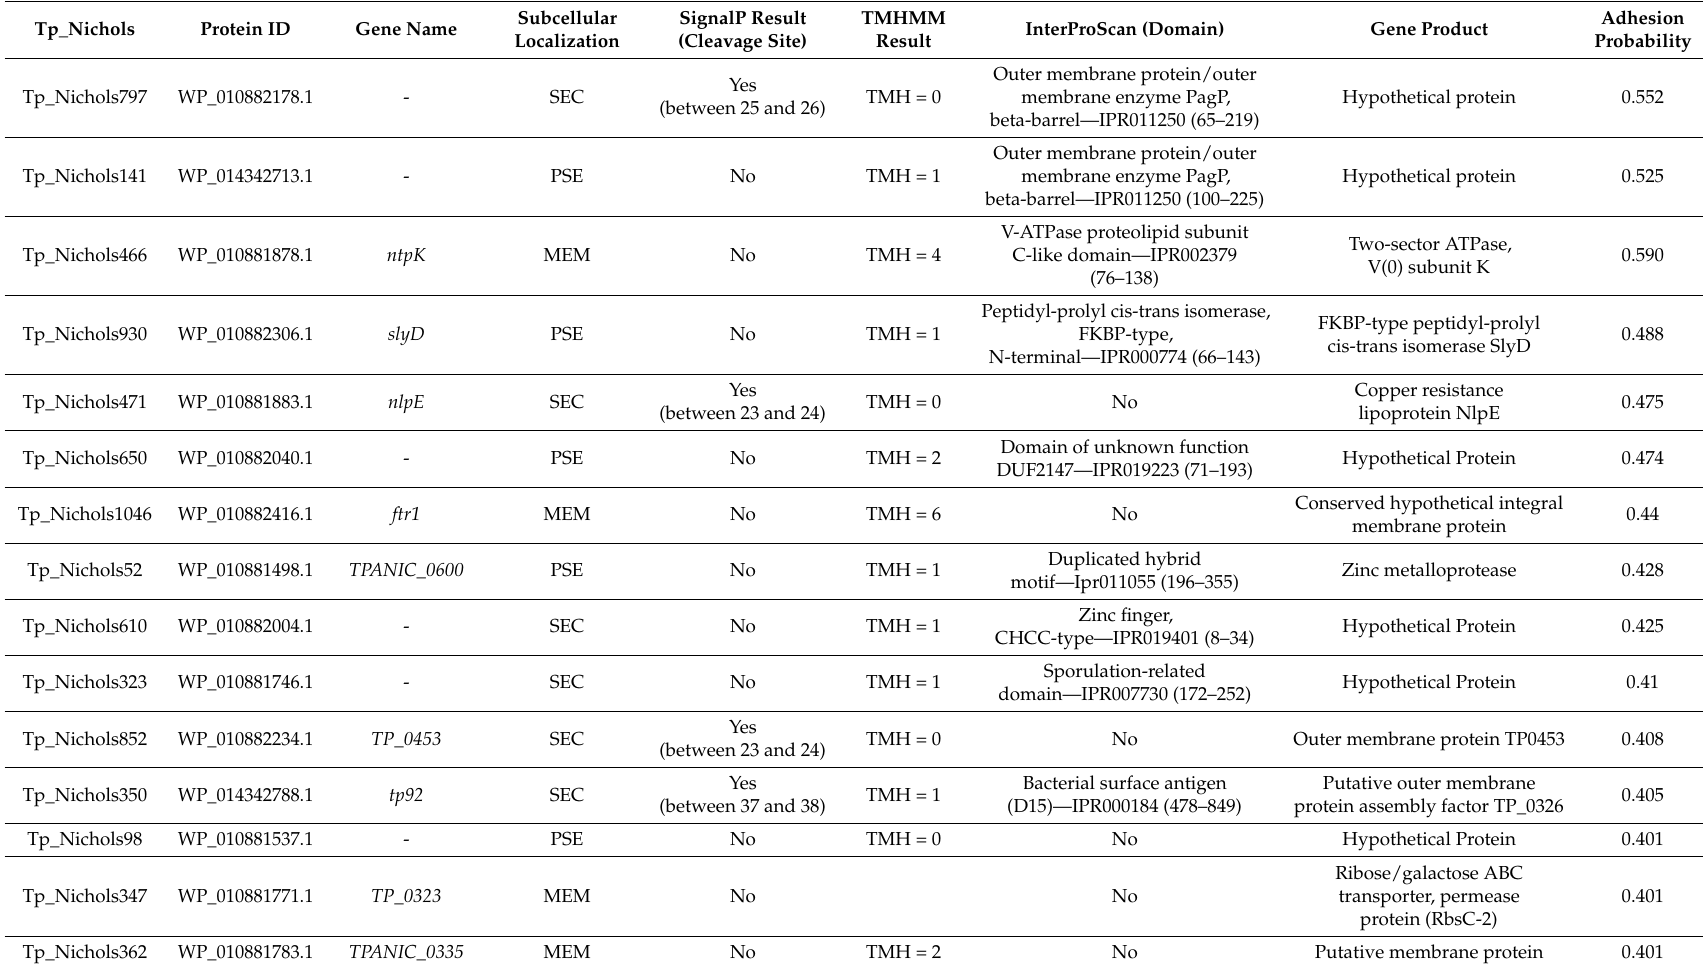
Table 3. Putative antigenic proteins of Treponema pallidum (Tp) identified using